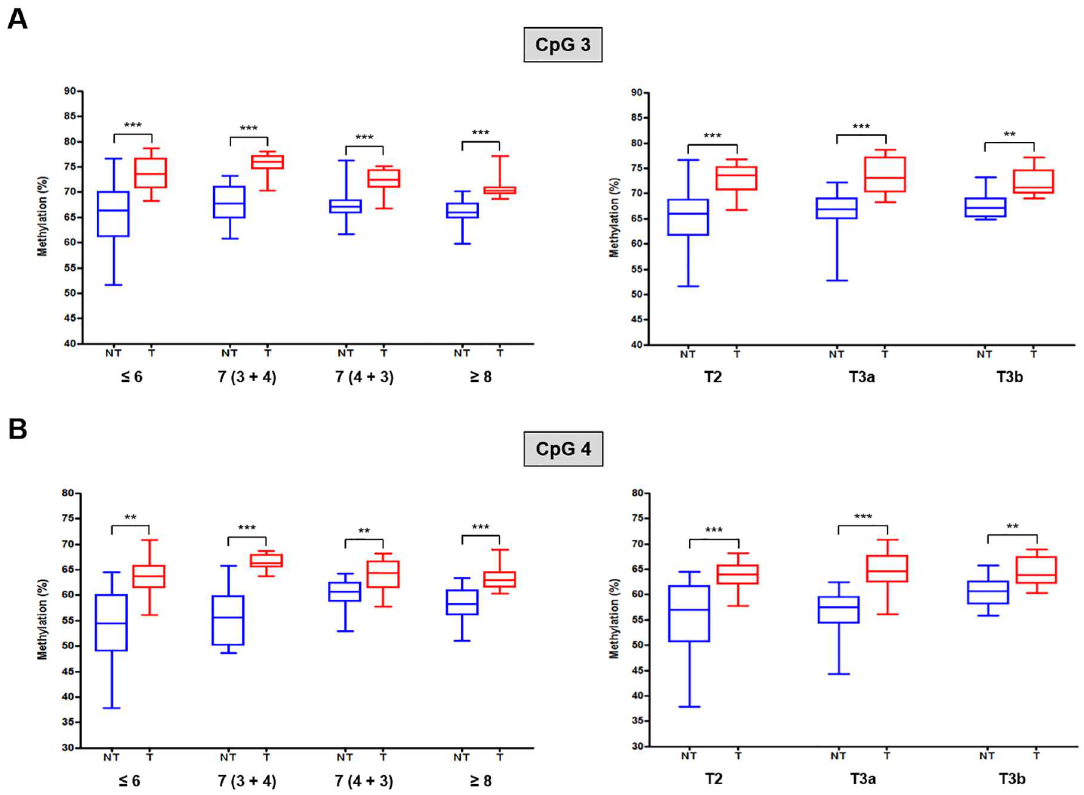
Fig 3. Association of the methylation frequencies of the (A) CpG 3 and (B) CpG 4 sites in the DEFB1 LCP with the corresponding Gleason scores and T stages of PCa tissues. Data shown in the blue box plots represent the methylation levels in non-tumor tissue samples, and data shown in the red box plots represent the methylationlevels in tumor tissue samples. NT, non-tumor; T, tumor. ** P < 0.01 and *** P <